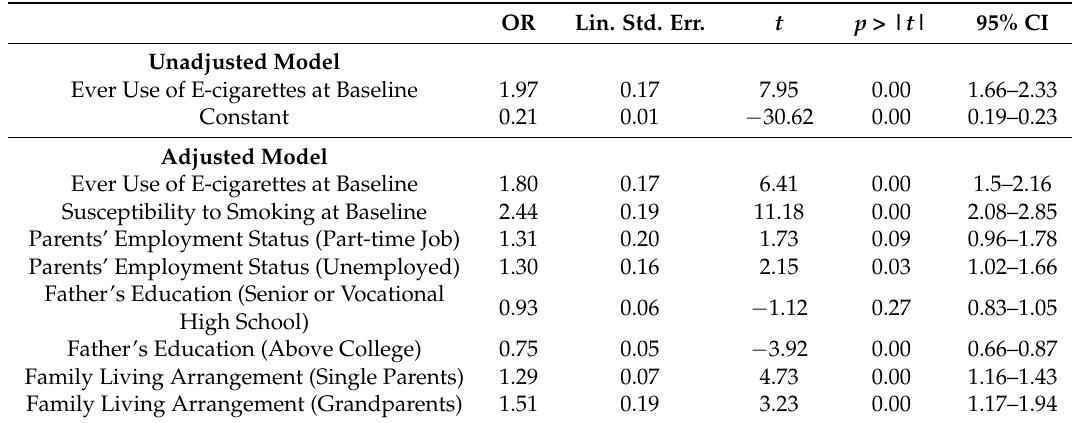
Table A3. Sensitivity Analysis: regression output assuming all the students lost at follow-up were smokers—weighted estimates (observations: